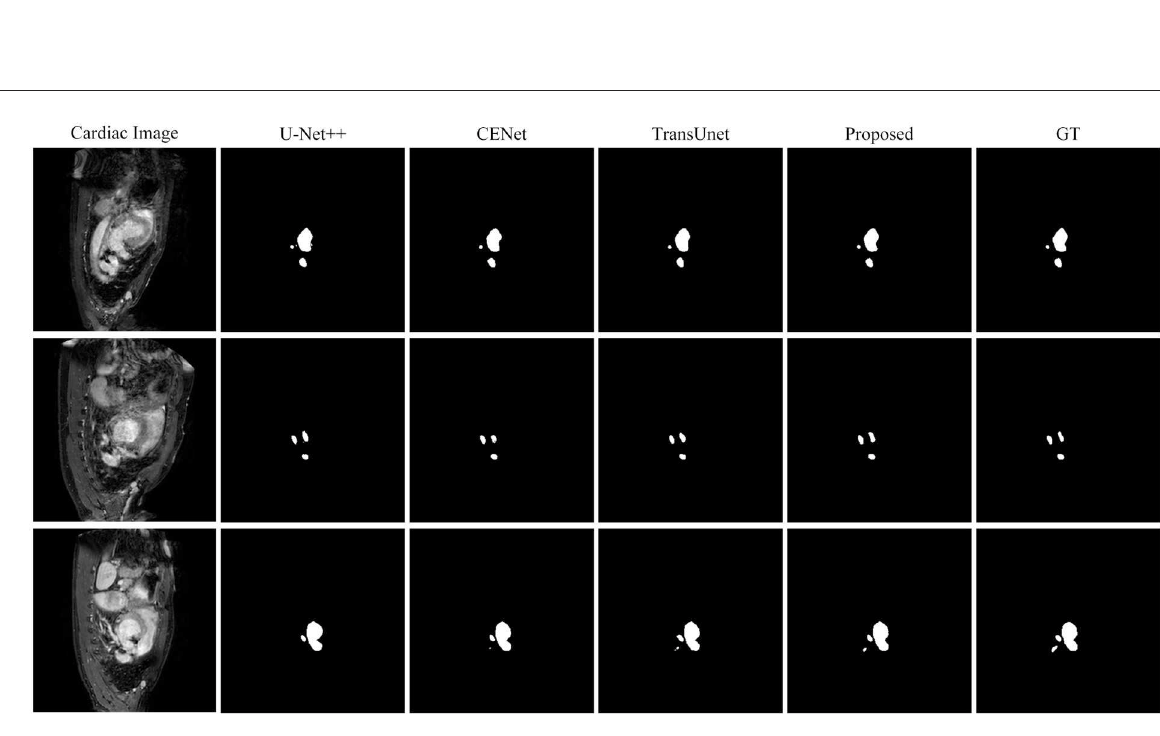
FIGURE5 Comparison of the proposed method and other state-of-the-art methods on the Cardiac